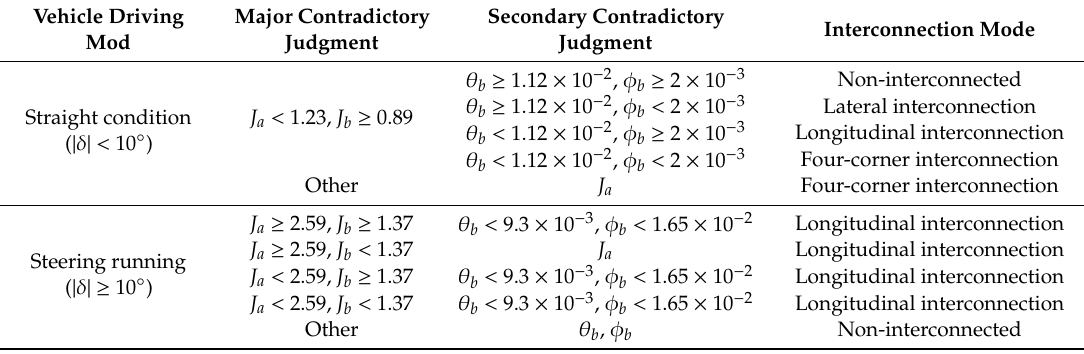
Figure 11. RMS value of pitch angle under the steering condition. Table 1. Control strategy of air suspension interconnection modes.